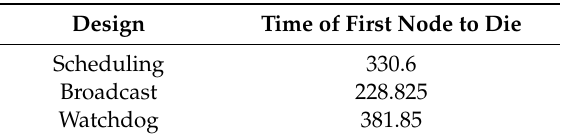
Table 9. First node to die.